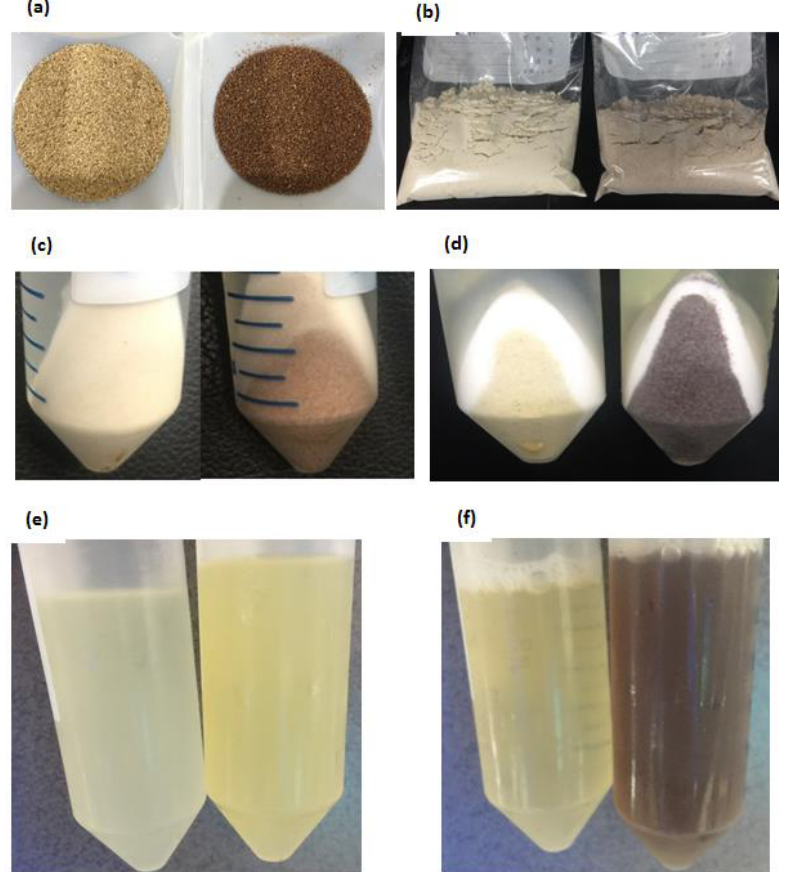
Figure 1 . Physical appearances of Mekel-W and Mekel-B during sample preparation. ( a ) Seeds (left to right; Mekel-W, Mekel-B), ( b ) Teff seed flour (left to right; Mekel-W, Mekel-B), ( c ) Residue before ethanol extraction (left to right; Mekel-W, Mekel-B), ( d ) Residue after ethanol extraction (left to right; Mekel-W, Mekel-B), ( e ) tert-butanol extract supernatants (left to right; Mekel-W, Mekel-B), ( f ) NaOH extract supernatants (left to right; Mekel-W, Mekel-B).